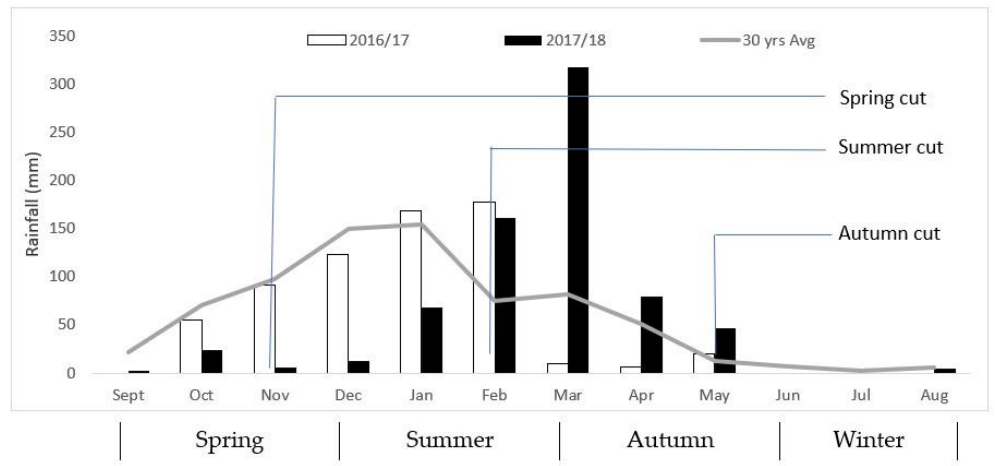
Figure 1. Time of harvest and long-term average and experimental average monthly rainfall (mm) for University of Pretoria Experimental Farm.